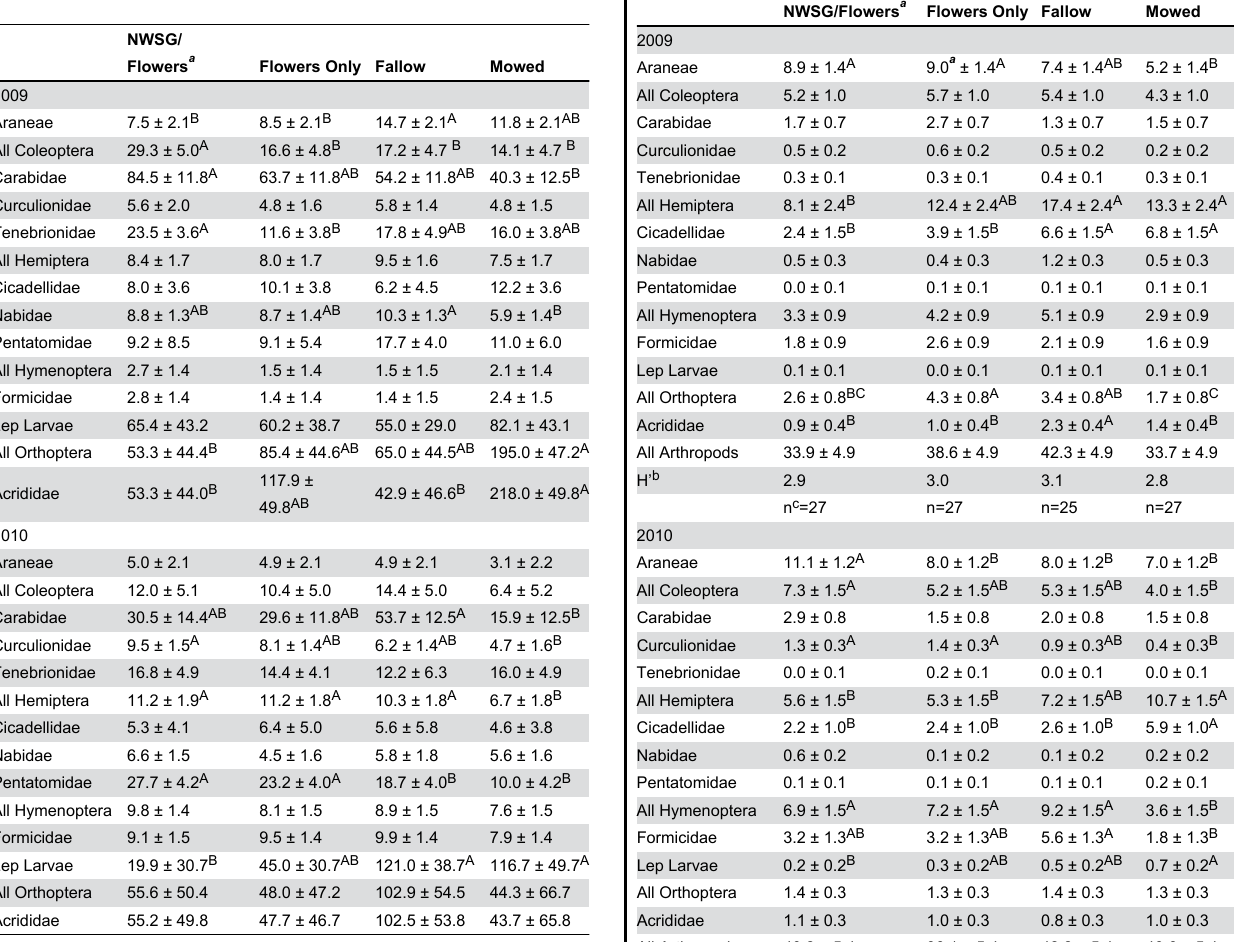
Table 3. Estimated least-square mean ± SE number of arthropods per 0.38 m 2 of most important taxonomic orders and families in four field border treatments (June to August 2009 and